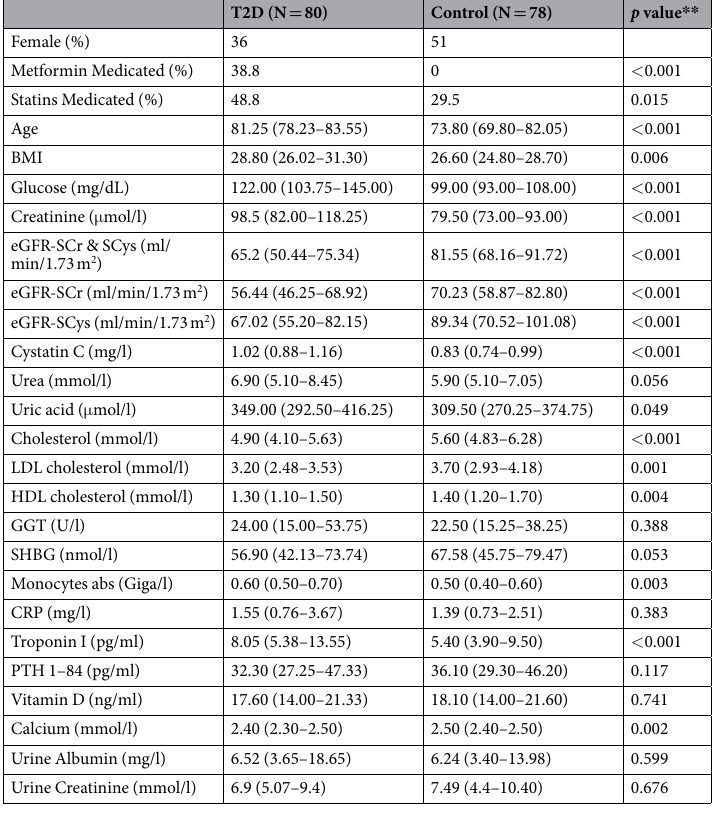
Table 1. Baseline characteristic of a nested case and control participants from ActiFE study (n = 159). BMI: Body Mass Index. eGFR: estimated glomerular filtration rate. LDL: low density lipoproteins. HDL: high density lipoproteins. SCr: serum creatinine. SCys: serum Cystatin C. GGT: gamma-glutamyl transferase. SHBG: Sex hormone-binding globulin. CRP: C-reactive protein. PTH: Parathyroid hormone.Data shown are median (interquartile range, Q1–Q3). * eGFR was calculated using serum Cystatin C and/or serum Creatinine